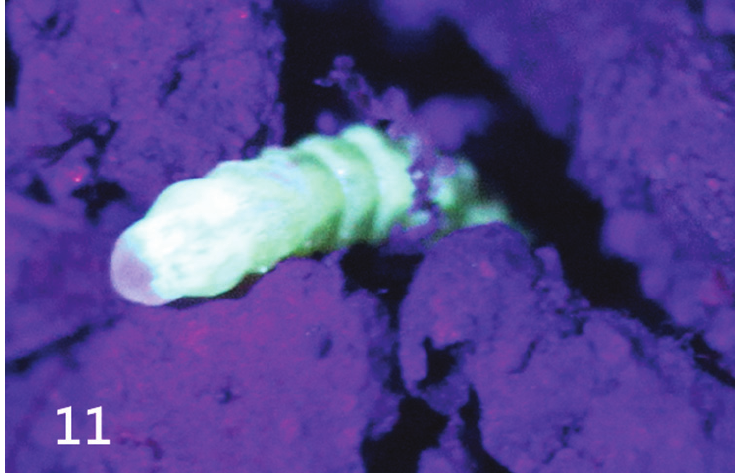
Figure 11. Oculogryphus chenghoiyanae sp. n., a female fluorescing in bluish green from body under ultraviolet illumination (UVA, 365–375